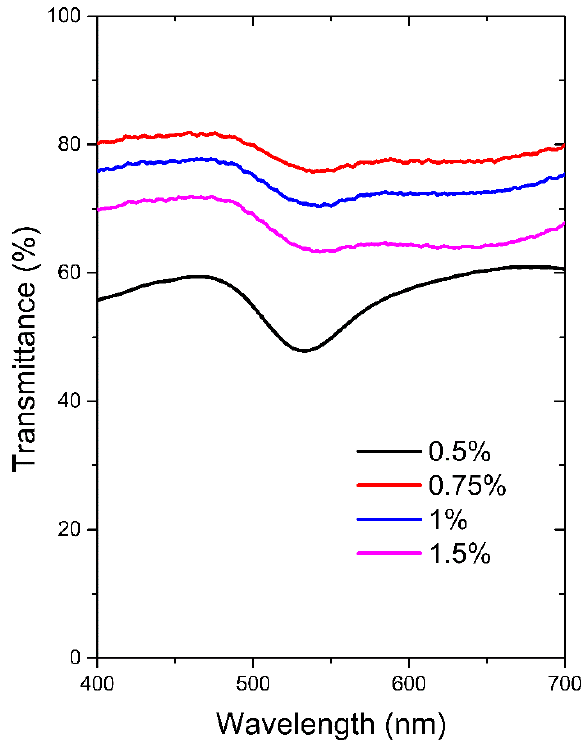
Figure 3. T ‐ LSPR spectra of produced chitosan membranes with Au NPs with different polymer Figure 3. T-LSPR spectra of produced chitosan membranes with Au NPs with different polymer concentrations (0.5, 0.75, 1, and 1.5%). concentrations (0.5, 0.75, 1, and